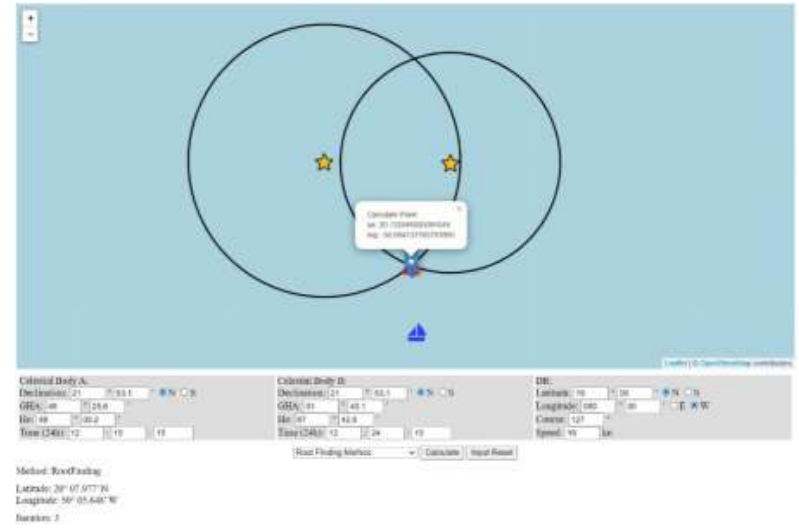
Figure 9. The GUI of Newton’s method calculation program (for Example 2).